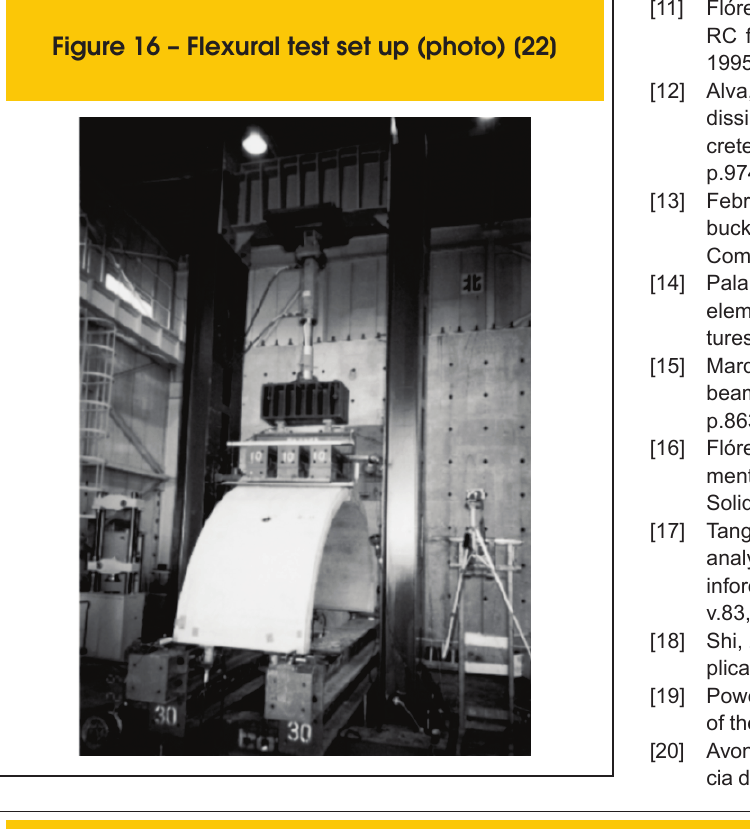
Figure 16 – Flexural test set up (photo) [22]